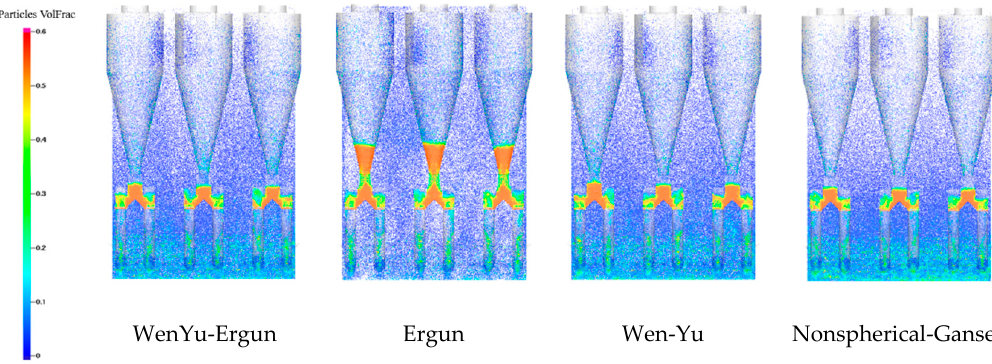
Figure 11. E ff ect of di ff erent drag models on the flow Figure 11. Effect of different drag models on the flow regime.